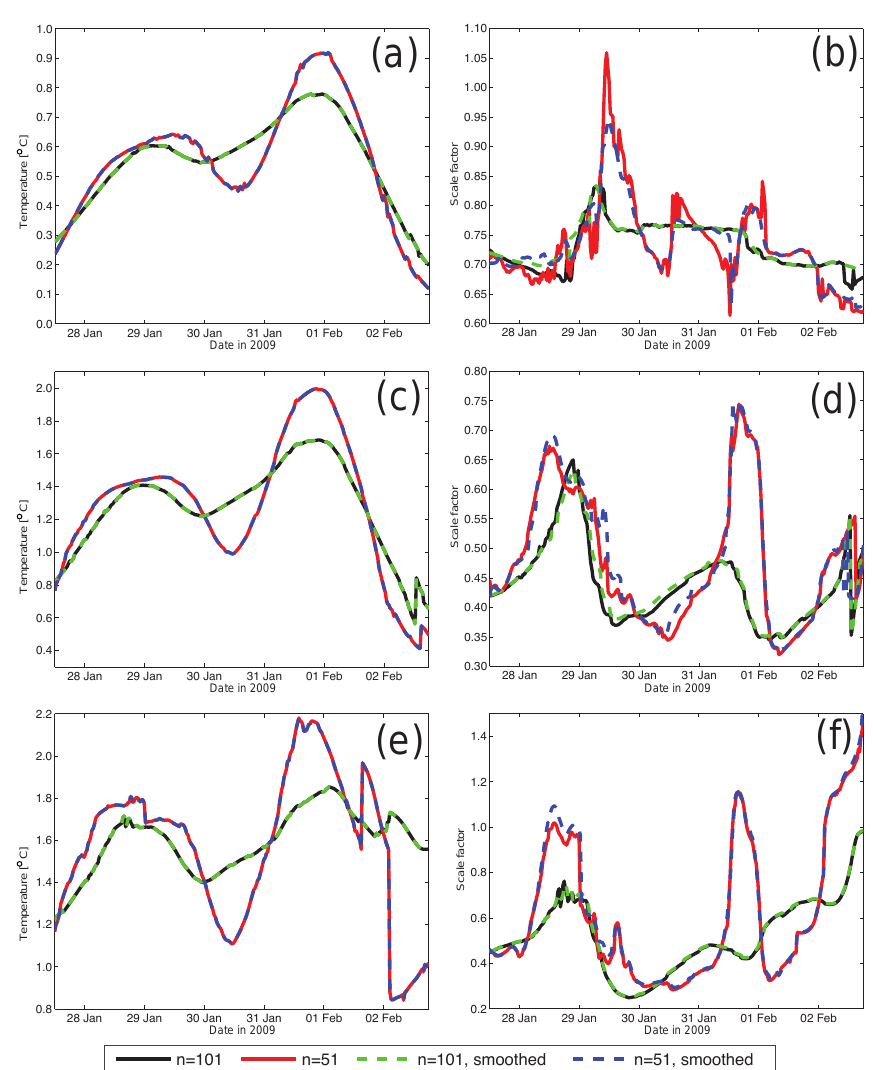
Figure 9. Epoch-wise biases (left panels) and scale factors (right panels) for the three pairs of loggers T1:T2 (top panels), T1:T3 (middle panels), and T1:T4 (bottom panels); for smoothing the centered moving mean of five samples was